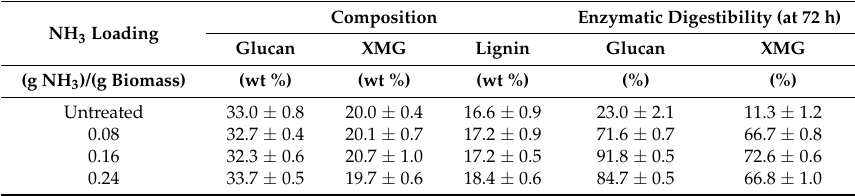
Table 2. Effects of ammonia loading on composition and enzymatic digestibility.